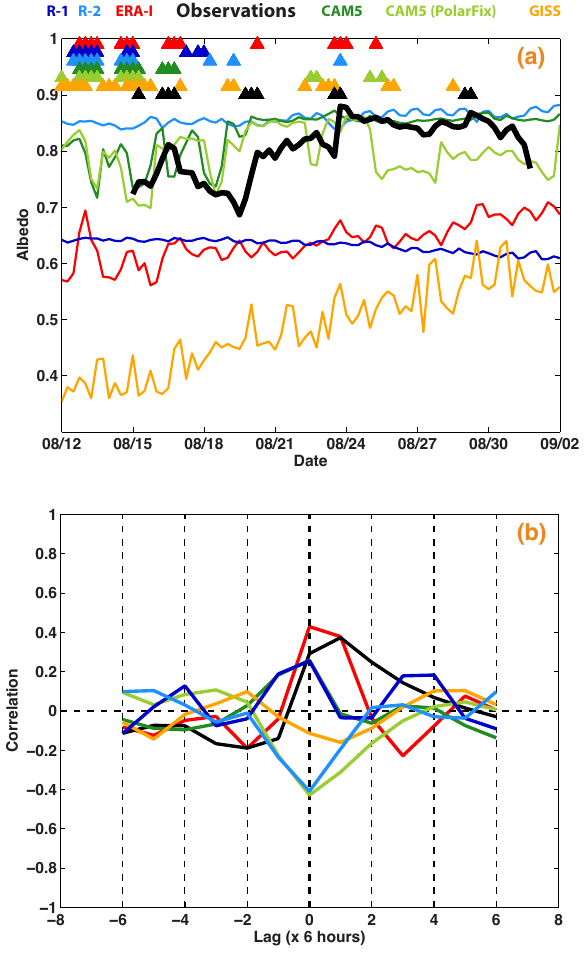
Fig. 5. Time series of surface albedo as calculated from the 6h av- erage shortwave radiation terms. Included are lines for the observa- tions from Oden (bold black line), CAM5 (standard version, dark green; CAM5-PF, light green), the GISS-ModelE2 (orange), and R- 1 (dark blue), R-2 (light blue) and ERA-I (red) reanalyses. Triangles along the top of the figure represent 6-hourly periods that averaged precipitation of 0.5mmh − 1 or greater.